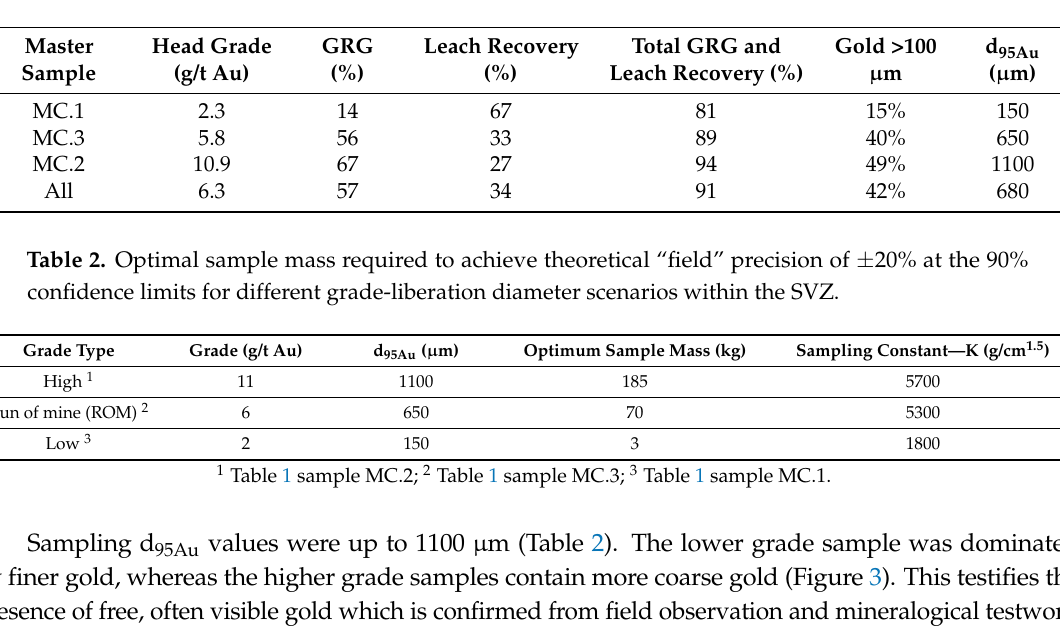
Table 1. Summary of ore characterisation testwork results in the SVZ.